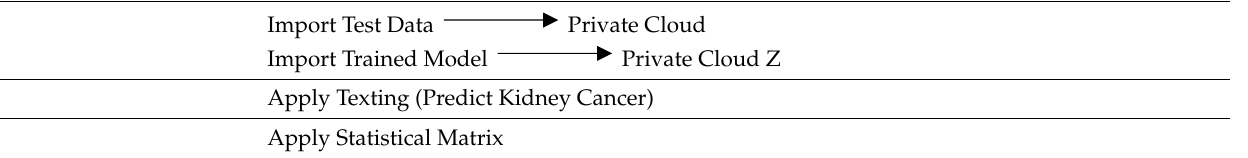
Table 2. Pseudocode IoMT-based proposed framework for the prediction of kidney cancer.